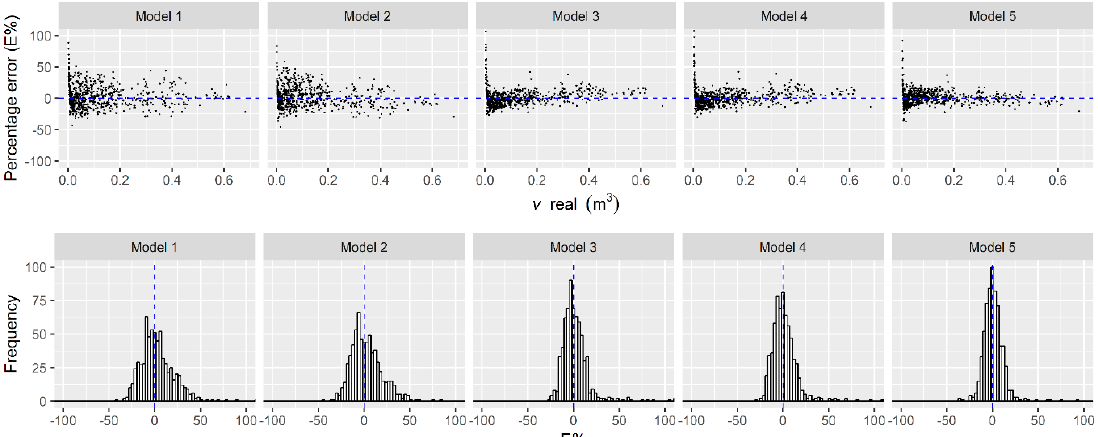
Table 4. Configurations, correlation coefficients between real and predicted values ( r y ŷ ), and weighted value (WV) of the best artificial neural network in the generalization of the approaches in scenarios (a) and (b).